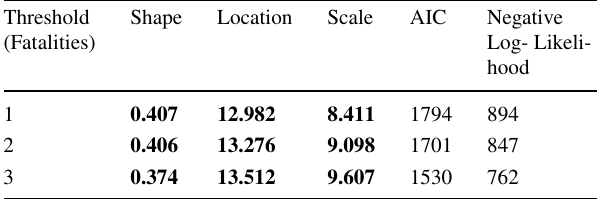
Table 3 Results of the estimated parameters for the point process (PP) stationary models with shape and location covariates